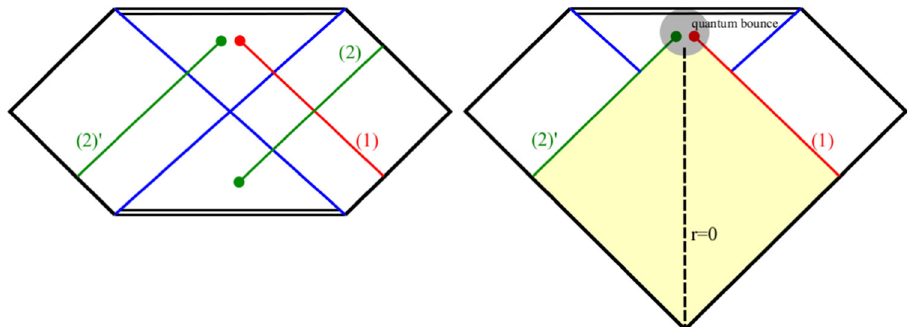
Fig. 3 Left: possible trajectories for (1) t = − r for t → −∞ and (2) t = r for t → +∞ on the Penrose diagram. The second branch can be interpreted in two ways: shell moving forward in causal time τ or